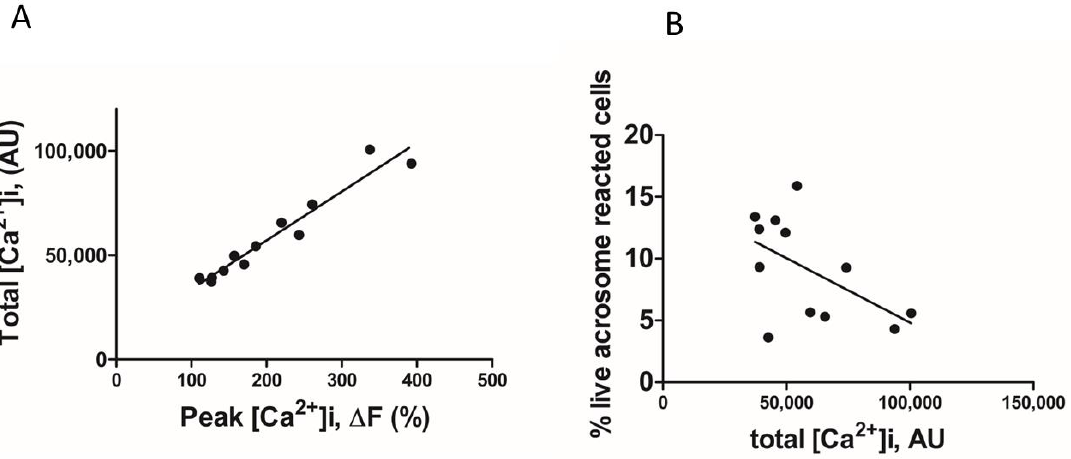
Figure 4. The relationship between P4/PGE1/NH 4 Cl-induced [Ca 2+ ]i response and acrosome reac-